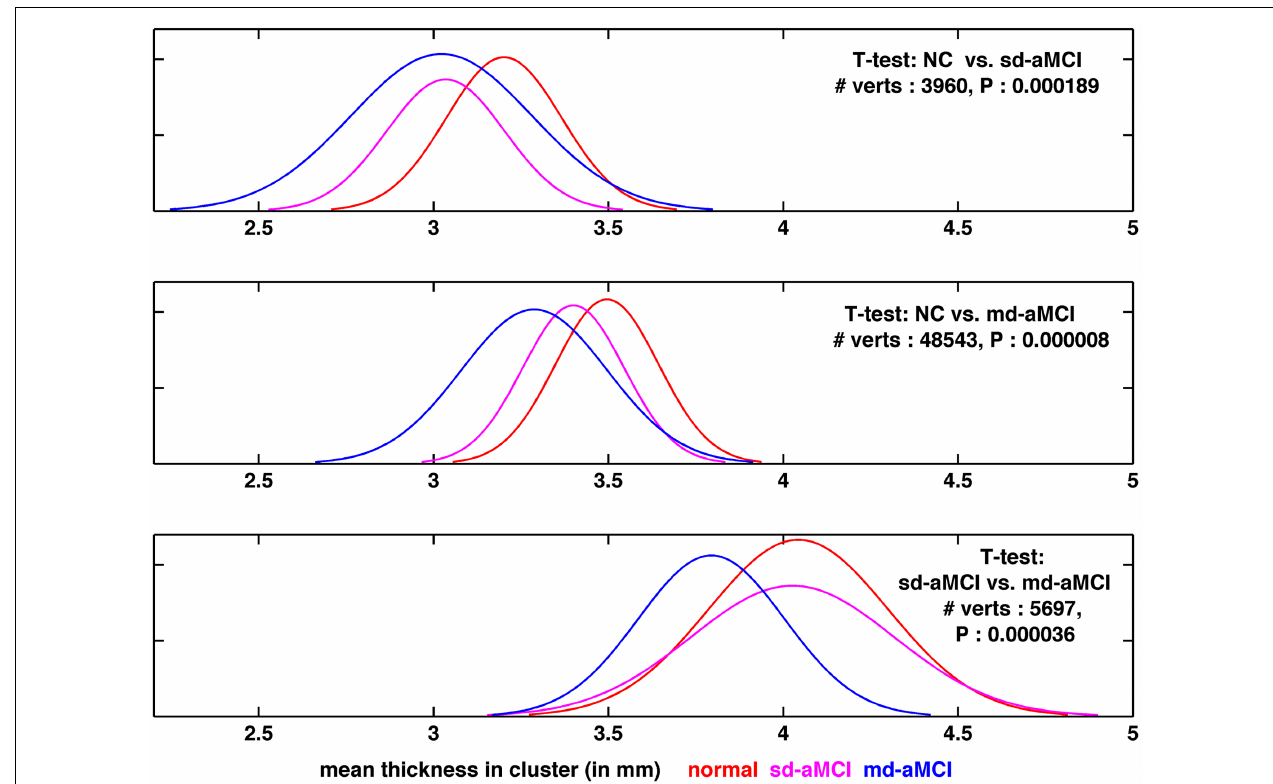
FIGURE 6 |Visualization of the distribution of thickness in the region found to be the most significantly different for each pair-wise comparison, as visualized in Figures 2B, 3B, and 4B, respectively from top to bottom